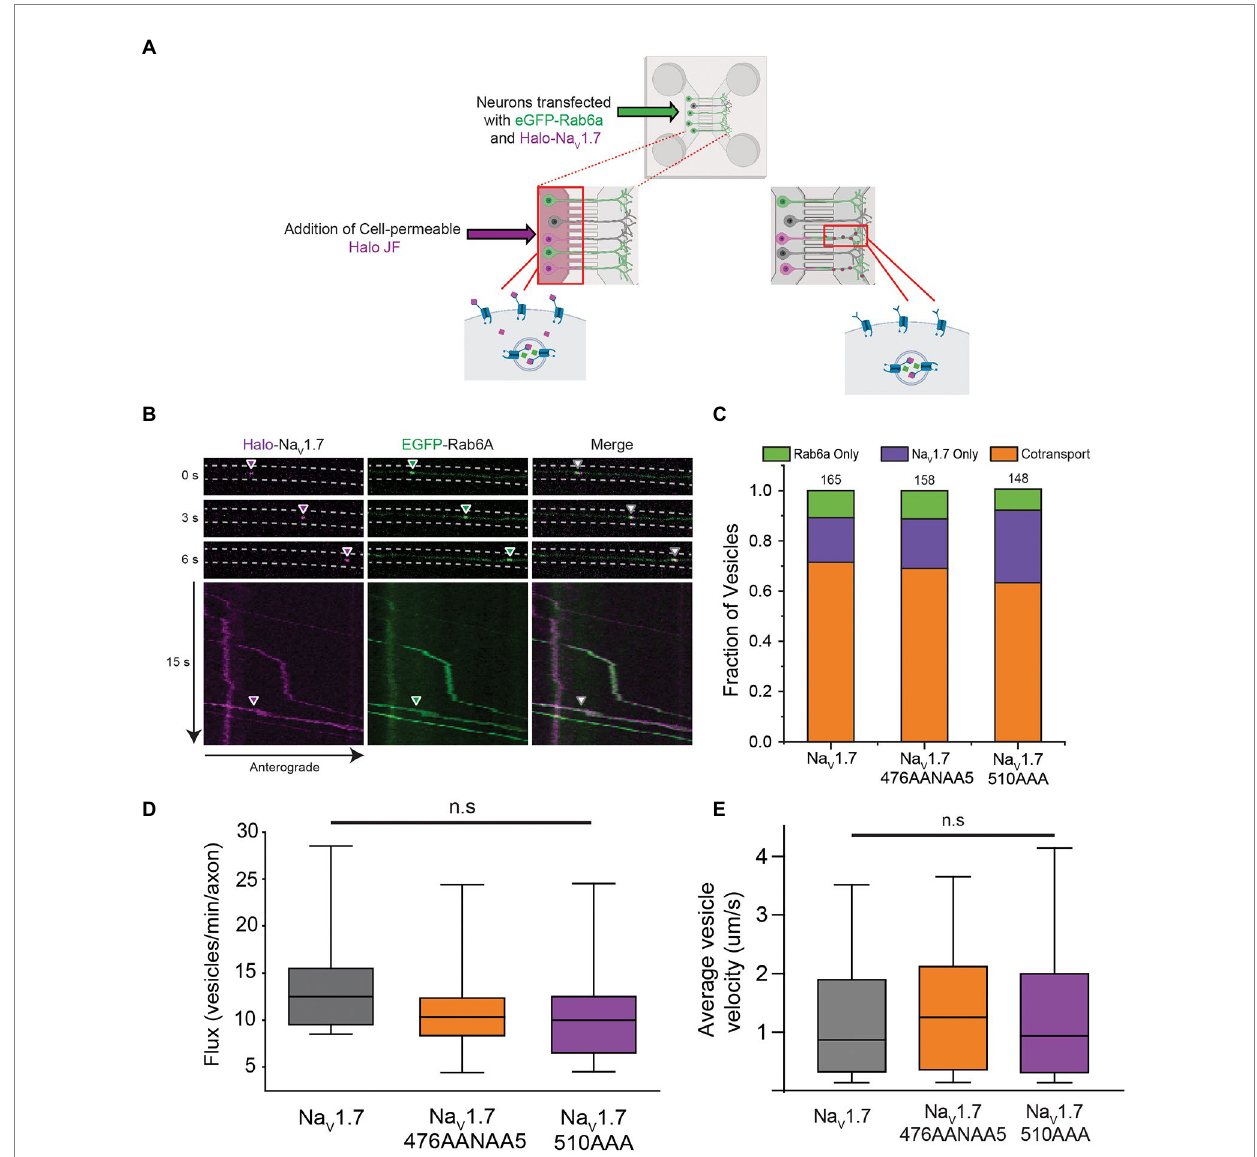
FIGURE 2 Co-transport of Na V 1.7 polybasic motif mutants with Rab6a. OPAL imaging was used to visualize anterograde vesicles carrying Halo-Na V 1.7 constructs labeled with JF646-Halo. Two-color time lapse imaging was performed to reveal vesicles carrying one or both of Halo-Na V 1.7 or EGFP-Rab6a (A) Schematic representation of the OPAL technique used to visualize channel trafficking. (B) Selected frames from a time lapse movie generated by a spinning disk confocal microscope where cells were excited by the 488 nm and 637 nm channels of the laser system. Arrowheads show the position of an anterograde vesicle containing Halo-Na V 1.7 (purple) and EGFP-Rab6a (green). Merged images show overlap of the green and purple signals indicating co-movement. The corresponding kymographs show the vesicle track, and the merged kymograph shows identical vesicle movement for both channels. (C) The fraction of vesicles that demonstrate cotransport of Na V 1.7 and Rab6a are not affected by mutation of either polybasic motif. Two-color time lapse imaging was performed. Kymographs were created for each construct-Rab6a pair, and vesicle tracks were visually inspected and classified as Rab only, Na V 1.7 only, or both ( p = 0.51; n = 148–165 vesicles per channel, 3 cultures, 7 axons per culture). (D) The flux of vesicles in neurons transfected with the polybasic motif mutant constructs was not different than in neurons transfected with WT Halo-Na V 1.7 ( p = 0.31; n =